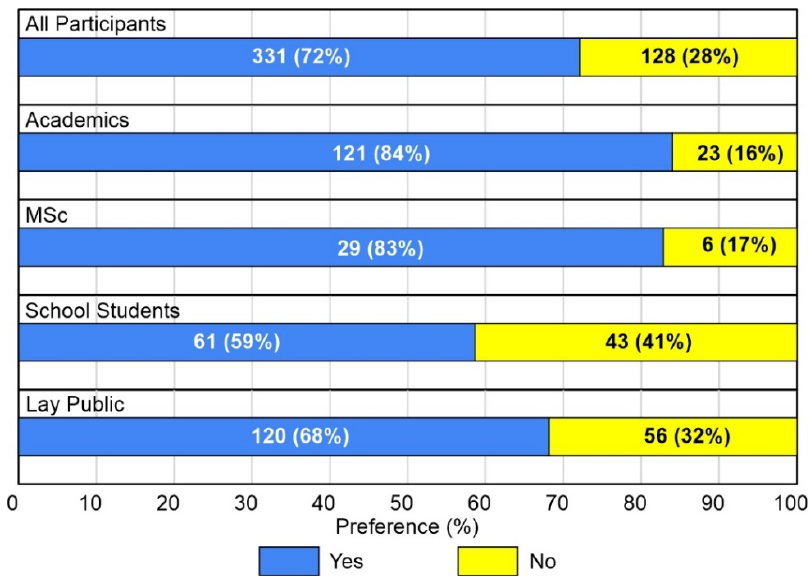
Figure 8. Bar charts showing the habits of the participants with regard to hiking/trekking. The results represent both the total number of participants and the background of each group respectively.